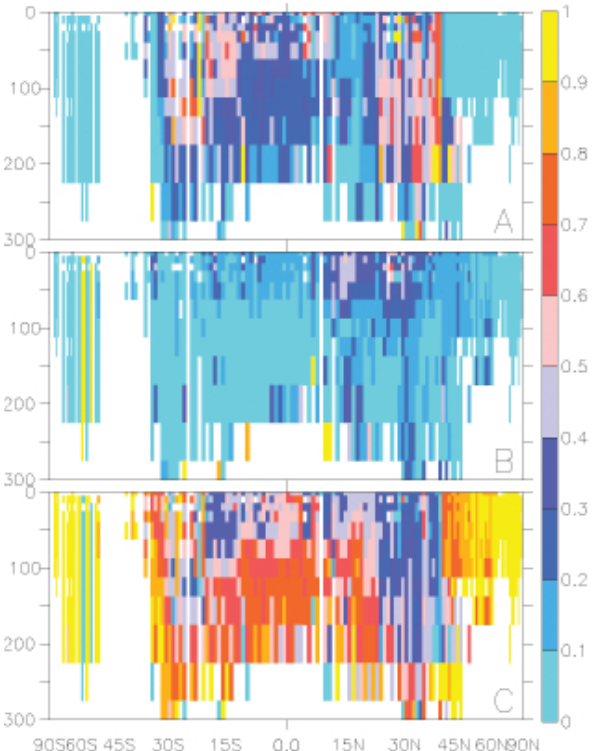
Figure 7. Zonal and time-averaged fraction of total picophyto- plankton (A) Prochlorococcus , (B) Synechococcus , (C) picoeukary- otes.